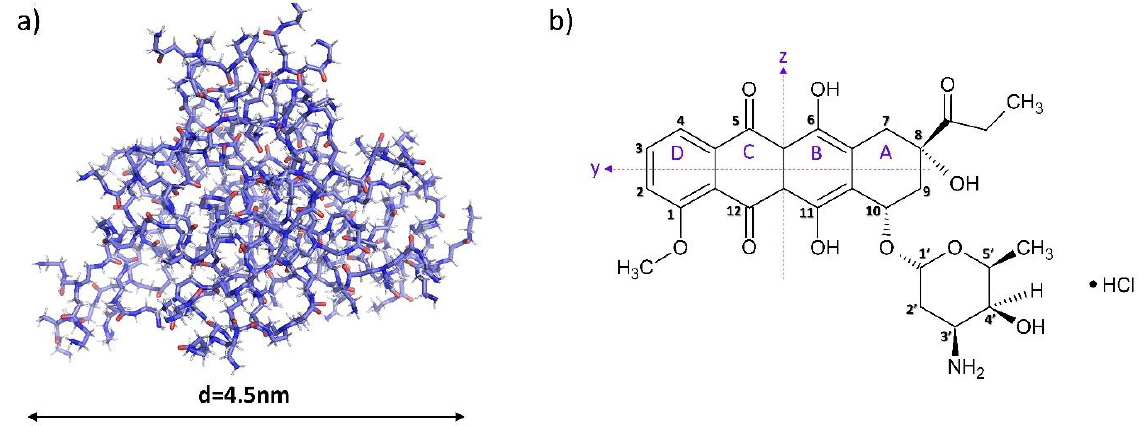
Figure 1. Structures of ( a ) G4.0 PAMAM dendrimer (The PyMOL Molecular Graphics System, Version 2.0 Schrödinger, LLC) and ( b ) doxorubicin hydrochloride (ACD/ChemSketch Freeware Version 2022.1.0).